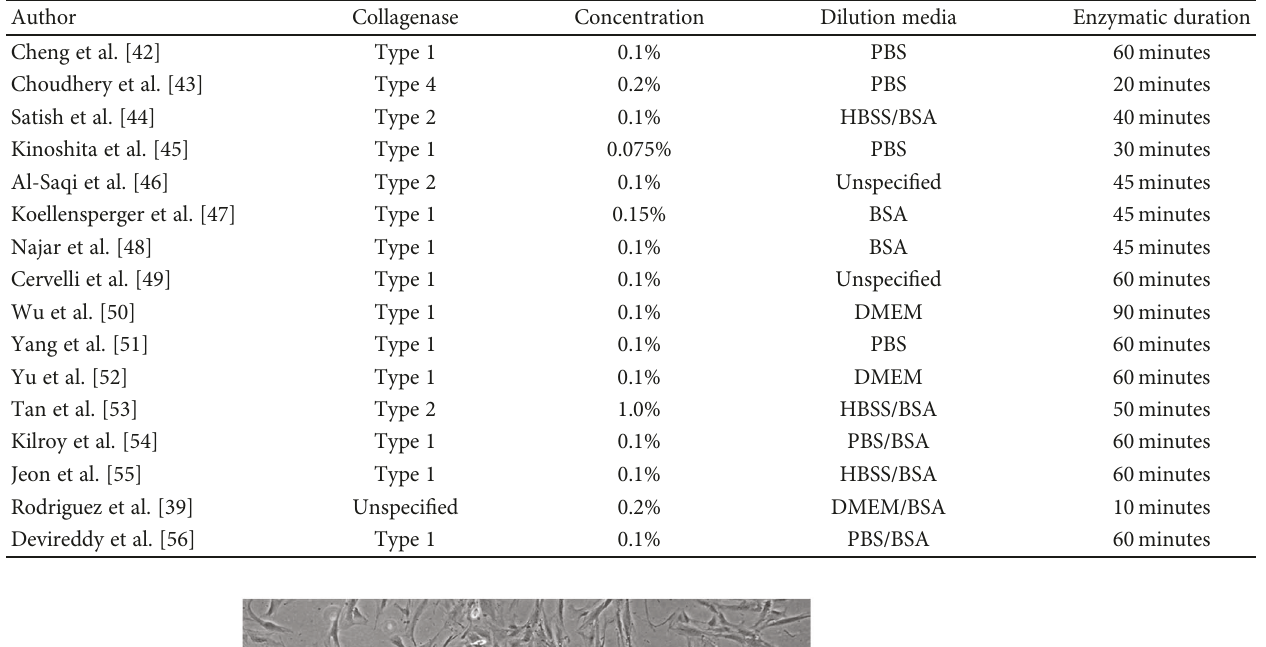
Table 1: Comparison of human studies using enzymatic breakdown with collagenase for ADMSC isolation from subcutaneous tissue. Phosphate bu ff er solution (PBS), Hank ’ s balanced salt solution (HBSS), bovine serum albumin (BSA), and Dulbecco ’ s modi fi ed eagle ’ s medium (DMEM).